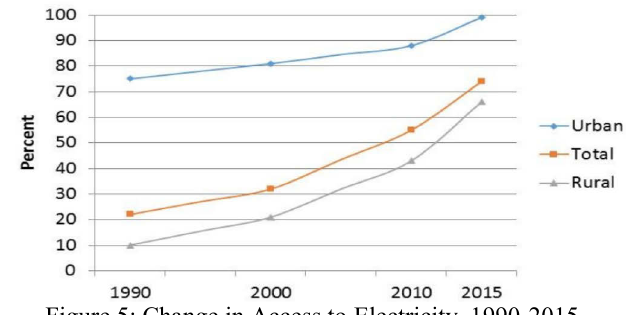
Figure 5: Change in Access to Electricity,